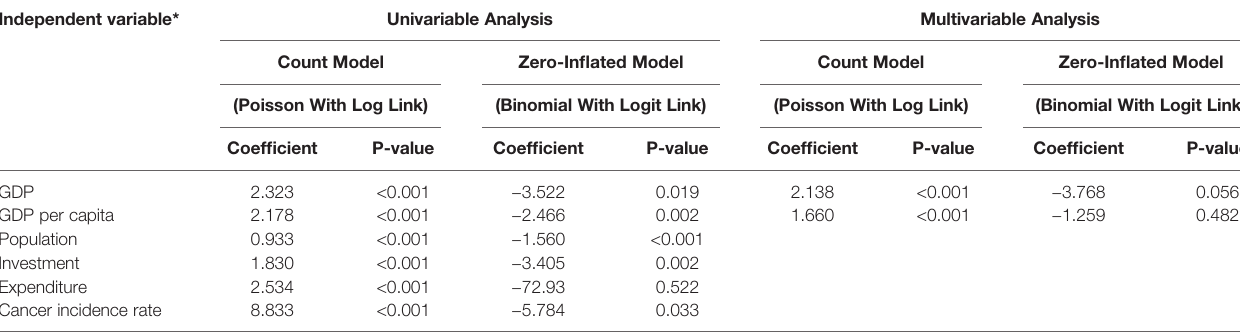
TABLE 2 | Univariable and multivariable analyses of determinants of number of PT centers. Independent